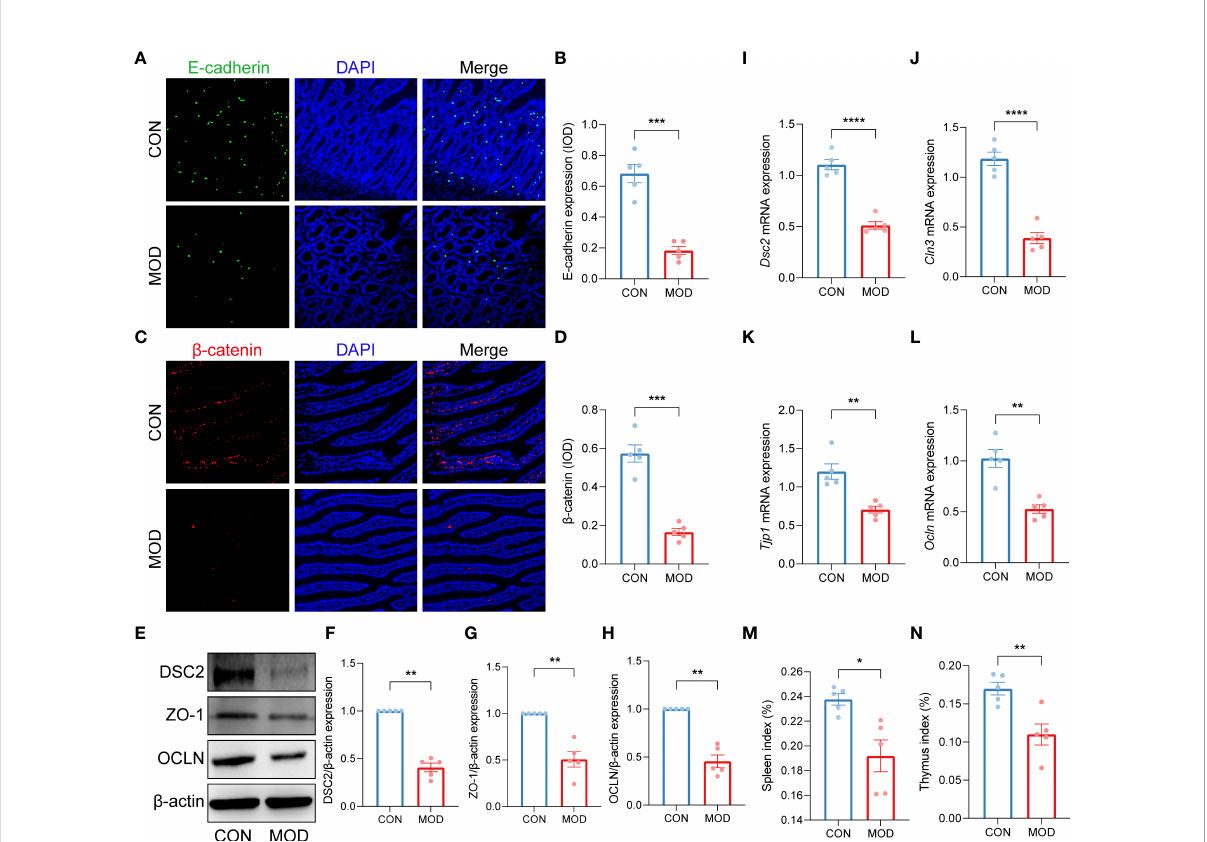
FIGURE 2 Impaired duodenal mucosal barrier was accompanied with decreased immune organs index. (A-D) Duodenal immuno fl uorescence staining (A, C) and the relative expression (IOD) of E-cadherin (B) and b -catenin (D) (*** p < 0.001 by unpaired t test with Welch ’ s correction). (E-H) The WB bands (E) and scaled normalized protein expressions of DSC2 (F) , ZO-1 (G) and OCLN (H) (** p < 0.01 by Mann Whitney test). (I-L) The relative mRNA expression of Dsc2 (I) , Cln3 (J) , Tjp1 (K) and Ocln (L) (** p < 0.01, **** p < 0.0001 by unpaired t test with Welch ’ s correction). (M, N) Indexes of spleen (M) and thymus (N) (* p < 0.05, ** p < 0.01 by unpaired t test with Welch ’ s correction). The circles on the bar plots represent individual values with mean ± SEM (bars) ( n = 5